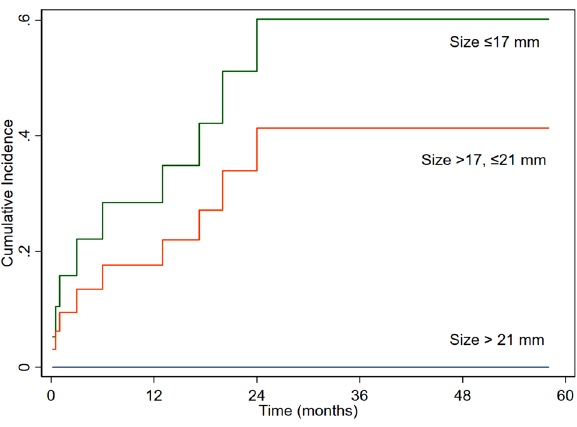
Figure 2. Cumulative incidence of mitral valve reoperation according to valve size.